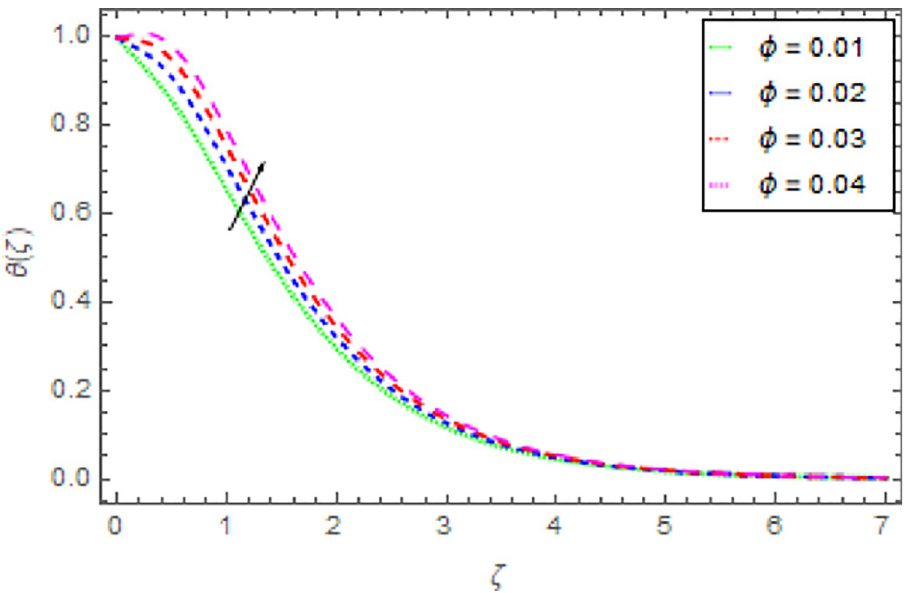
Fig 15. Deviation in nanofluid temperature against ϕ when Pr = 1000, m = 0.10, n = 1.00, M = 2.50, δ = 0.40, β = 1.00 and Nr =